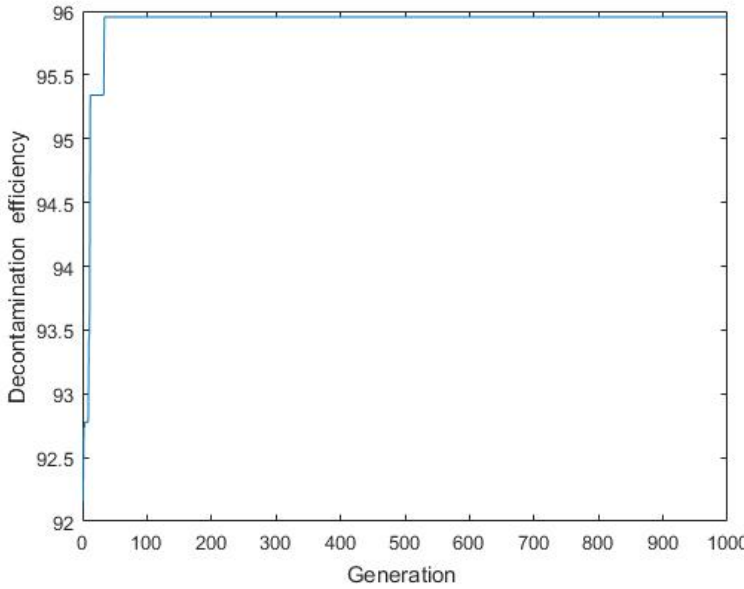
Figure 26. Decontamination efficiency versus generation.